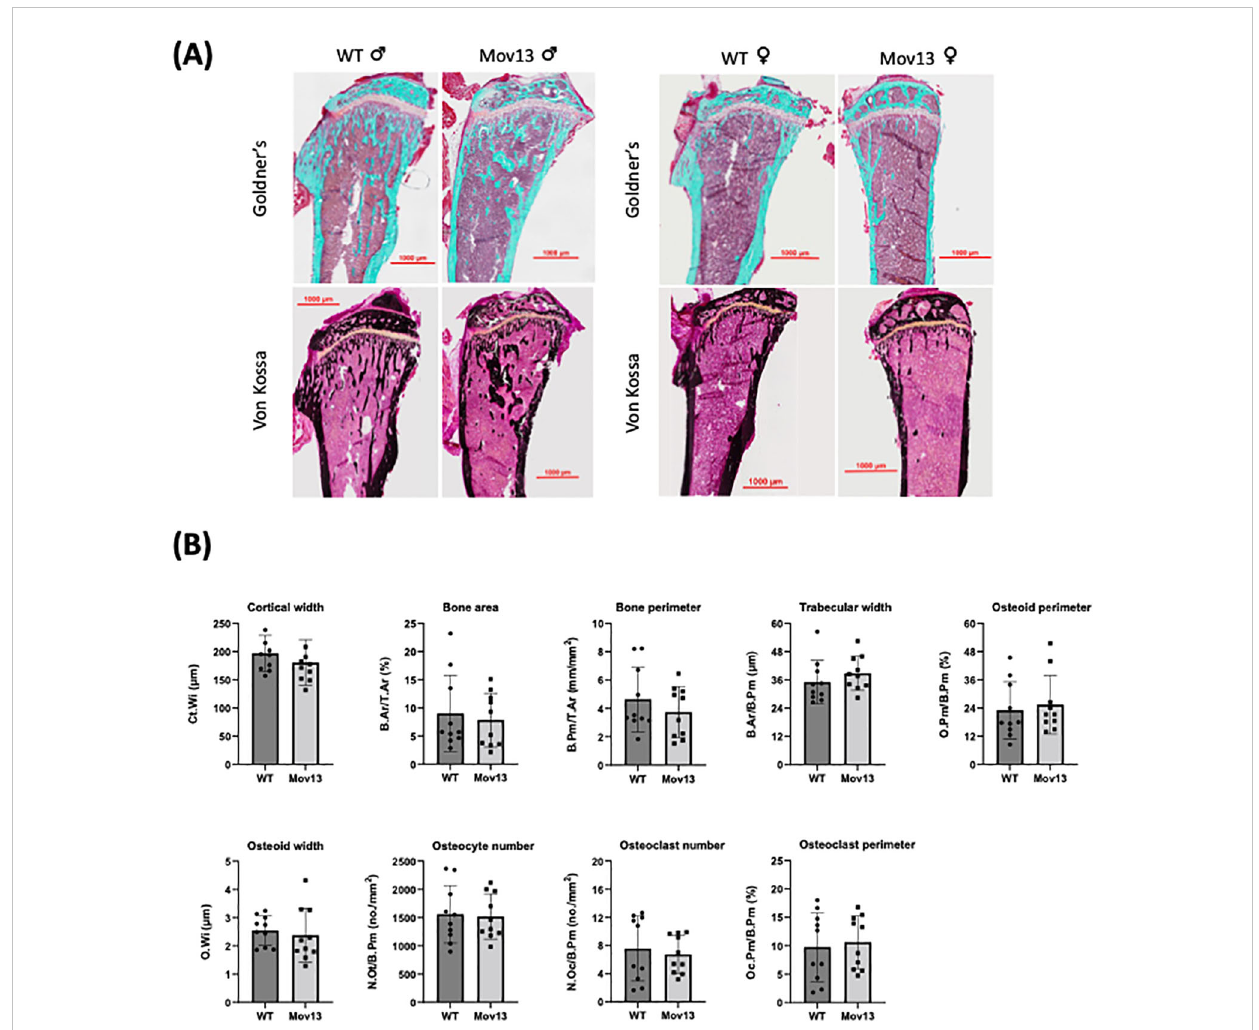
FIGURE 4 Histomorphometrical analysis of Mov13 and WT tibias. (A) Representative images of Mov13 and WT mice tibia bone histology. Masson Goldner ’ s trichrome (10x objective) and Von Kossa (20x objective) staining of male and female mice tibiae. (B) Cortical and trabecular measurements of Mov13 and WT tibias: Cortical width (Ct.Wi), Bone area (B.Ar/T.Ar), Bone perimeter (B.Pm/T.Ar), Trabecular width (B.Ar/B.Pm), Osteoid perimeter (O.Pm/ B.Pm), Osteoid width (O.Wi), Number of osteocytes (N.Ot/B.Pm), Number of osteoclasts (N.Oc/B.Pm), Osteoclast perimeter (Oc.Pm/B.Pm). Values of standard deviation (SD) are shown for each group: WT (n=10, 50%male), Mov13 (n=10, 50%male). Statistical signi fi cance is indicated on the graphs (P-values ≤ 0.05 (*)). Bv/Tv, B.Pr/T.Ar and O.Wi were measured with a non-parametric unpaired